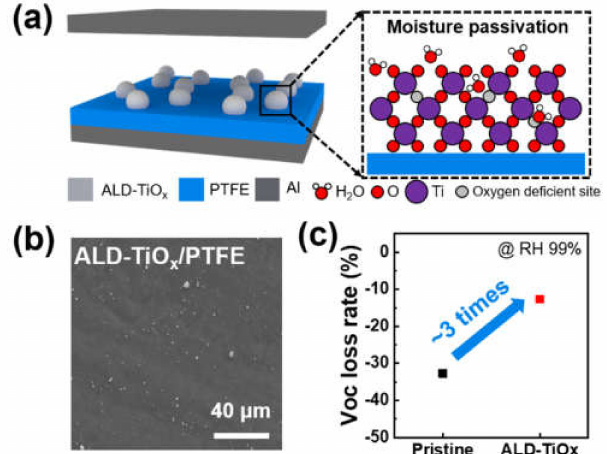
Figure 1. Concept and effectiveness of humidity passivation using ALD-TiO x . ( a ) Schematic illustra- tion of humidity passivation using ALD-TiO x . ( b ) FE-SEM image of the ALD-processed TiO x /PTFE film. ( c ) Open circuit voltage (V OC ) loss rate of pristine PTFE and ALD-TiO x -deposited PTFE film at relative humidity (RH) of